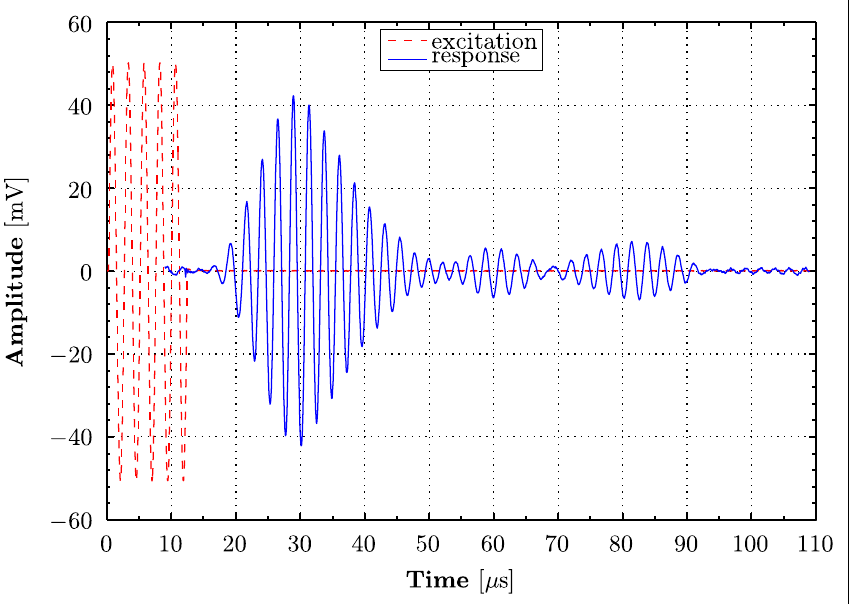
Figure 5. Excitation signal (scaled 1:100) and an example of the Lamb wave response for the A5B4 wave propagation path (undamaged condition).